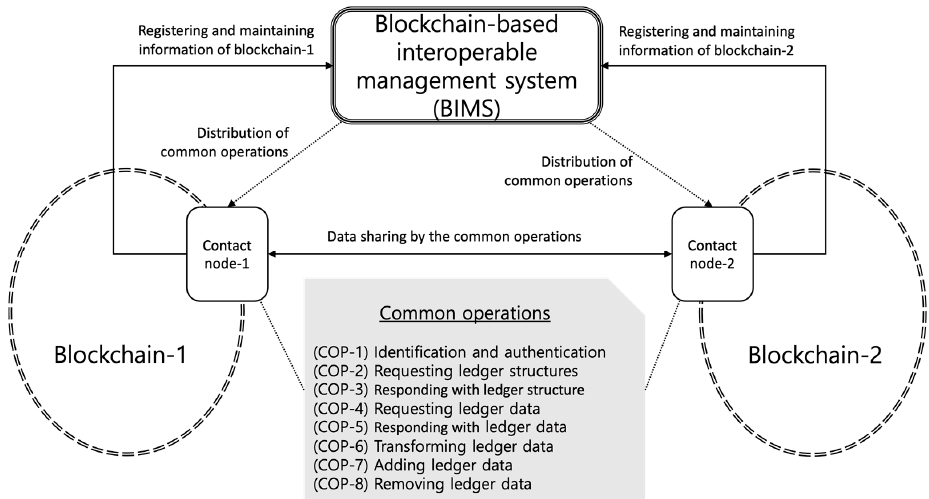
Figure 1. The interoperable architecture between heterogeneous blockchains.